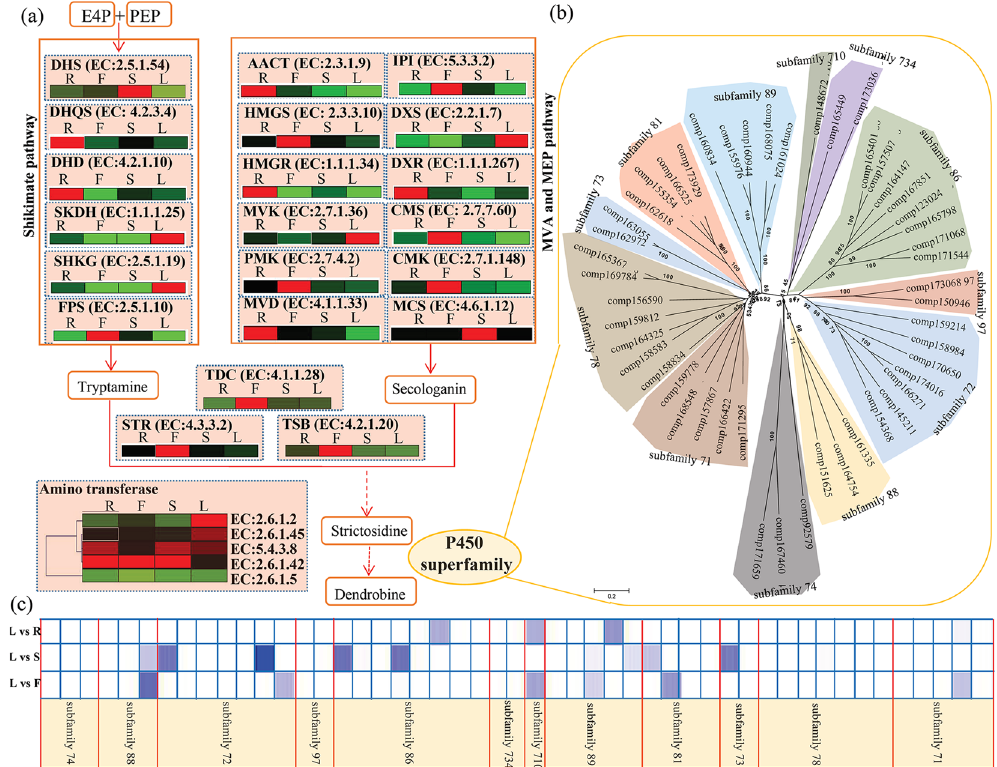
Figure 5. Expression pattern of the unigenes associated with putative alkaloid biosynthesis in D. officinale . ( a ) Expression pattern of the unigenes associated with putative upstream elements of alkaloid biosynthetic pathway. Full names of enzymes represented by their abbreviated names were showed in Table S7. The average expression level of the enzyme encoding unigenes in various organs is indicated by a heat map. The grids with different colors from green to red show the relative expression levels to maximum RPKM values, from 0 to 100%, respectively. ( b ) Phylogenetic analysis of all P450 genes with full-length cDNA from D. officinale . Branches in different background colors indicated different subfamilies. ( c ) Significance analysis of P450 genes in three leaf contained comparisons, including L vs R, L vs S and L vs F. The grids with different shades of blue show the different significant values, from 0 to